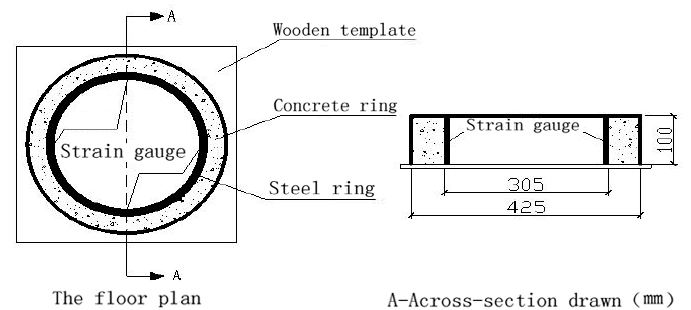
Figure 4. Schematic diagram of the plat-ring-type test.